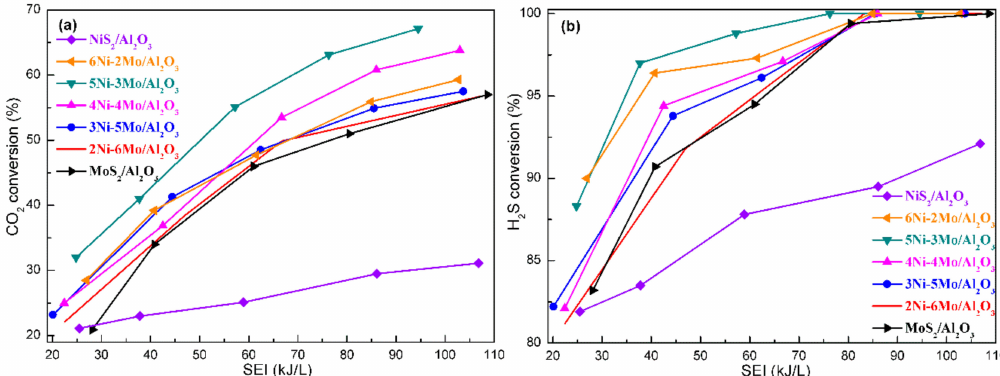
Figure 5. The conversions of CO 2 ( a ) and H 2 S ( b ) as a function of SEI on the Ni-Mo sulfide / Al 2 O 3 catalysts with various Ni / Mo molar ratios. Reaction conditions: feed: H 2 S / CO 2 molar ratio = 20:15; flow rate: 35 mL / min; catalyst bed volume: 15.0